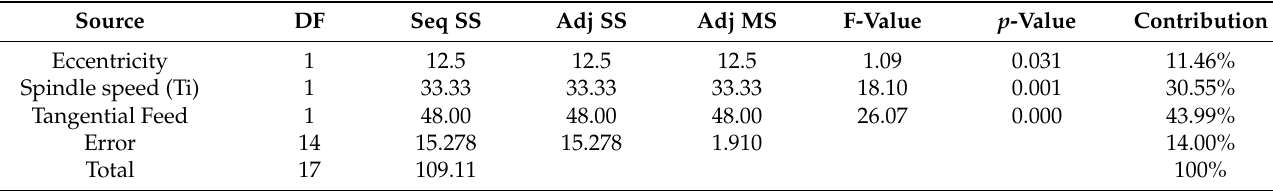
Figure 8. Main effects plot of circularity error in Ti6Al4V hole-making.